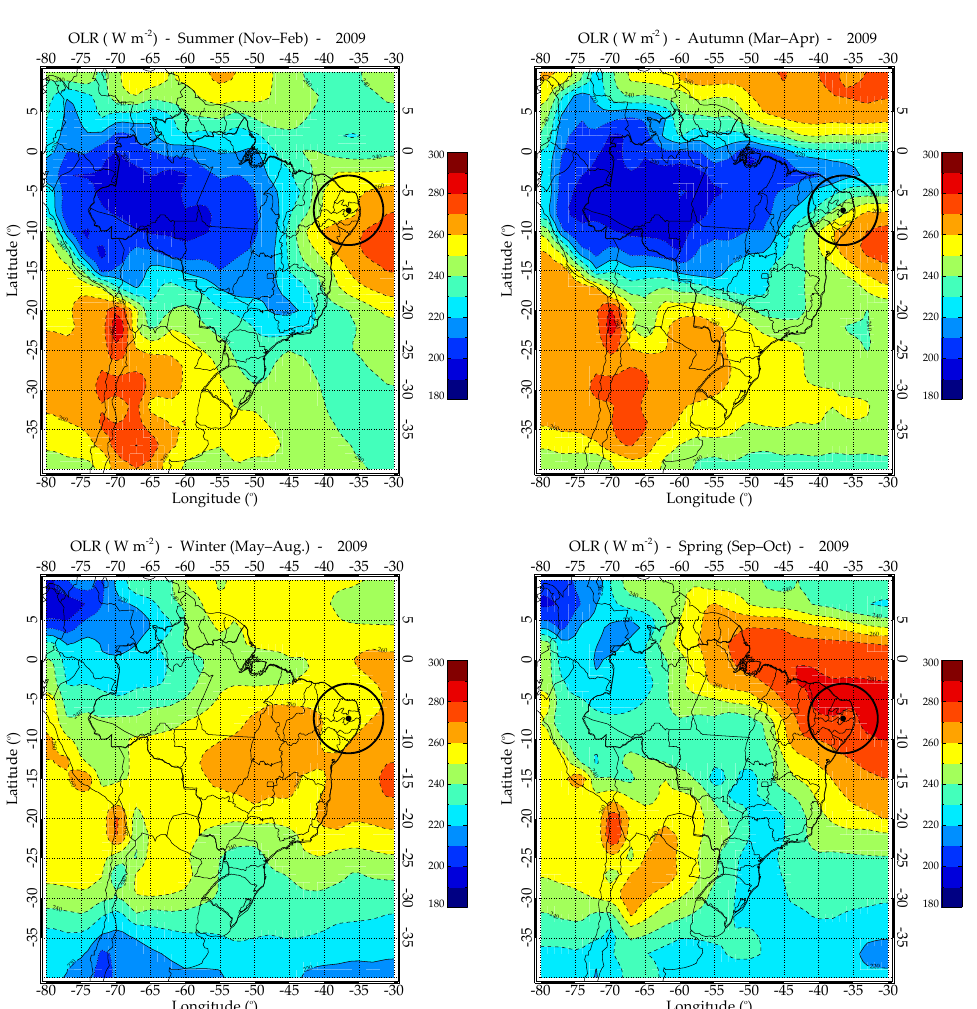
Figure 9. The average daily mean of the outgoing longwave radiation (OLR, in Wm − 2 ) over South America for each season in 2009 during AGW observations at